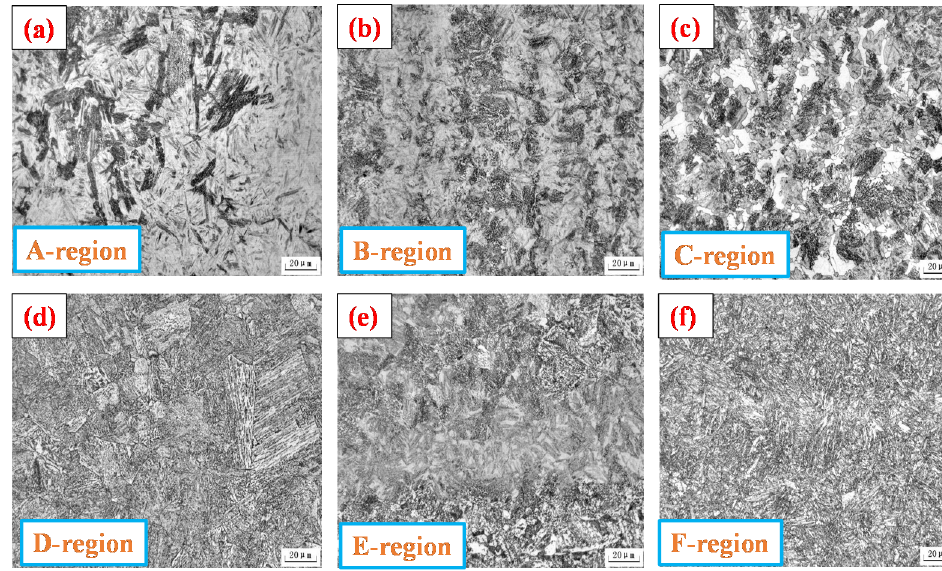
Figure 4. Metallographic structure analysis results.